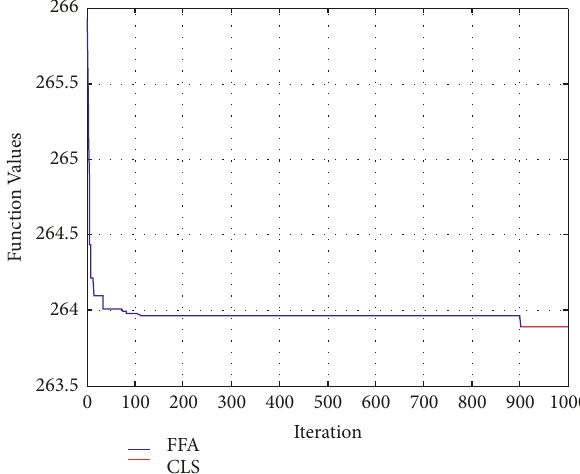
Figure 9: CFFA ′ s convergence curve of the three-bar truss design problem before and after